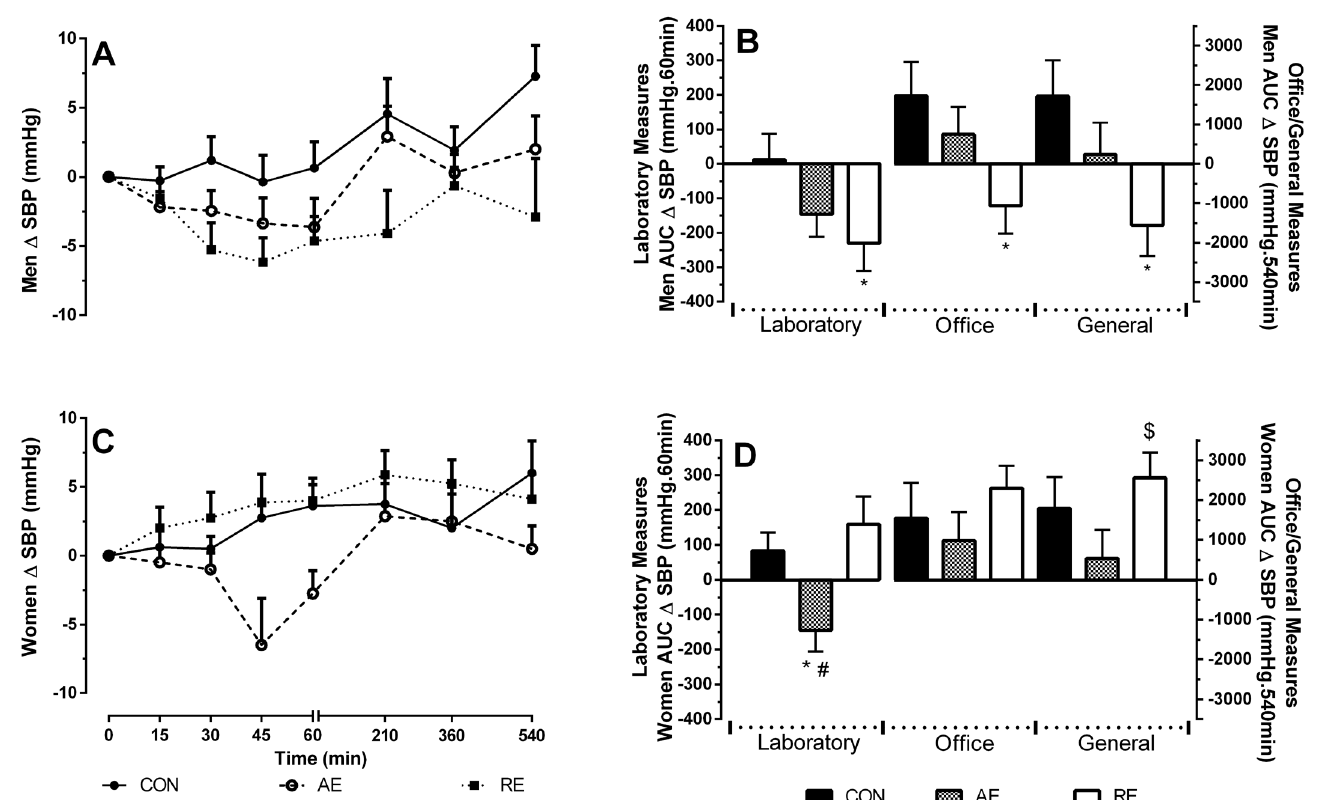
Figure 2. Delta and AUC of SBP of men and women; Time-related responses in delta SBP are present in the left side (panels A and C) and the correspondent AUC of SBP are present in the right side (panels B and D); The upper panels depict men and bottom panels depict women results; Right graph: Left Y axis: 1 hour on the laboratory; Right Y axis: 8 hours on the work place and general; AE- Aerobic session; AUC- Area Under the curve; CON- Control session; RE- Resistance session; SBP- Systolic blood pressure; * Difference with CON; $ Difference with AE. # Dif - ference with